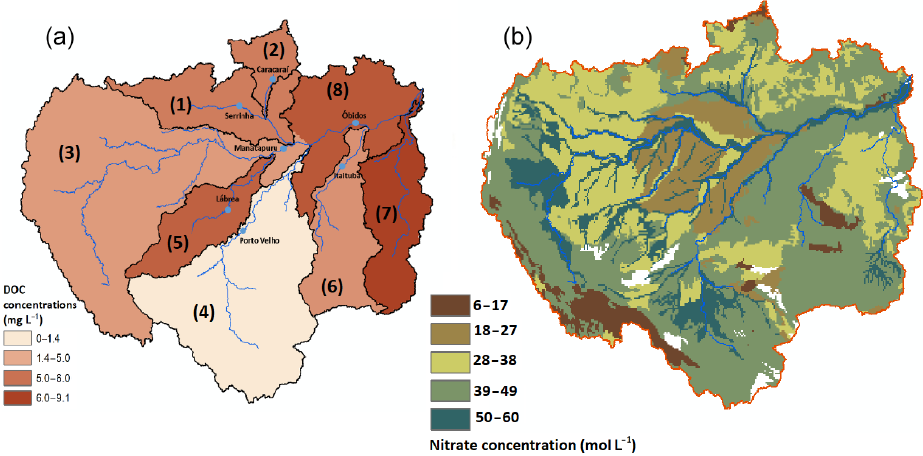
Figure 3. Map of the spatial inputs of the denitrification model. DOC contents (mgL − 1 ) mapped over each sub-basin of the main streams (January) with local observation gauging stations in blue circles (a) . The Amazon watershed is divided into eight major sub-basins: (1) the Negro basin, (2) the Branco basin, (3) the Solimões River and its tributaries, (4) the Madeira basin, (5) the Purus basin, (6) the Tapajós basin, (7) the Xingu basin and (8) the section between Manaus and the mouth of the Amazon River. NO − FAO’s types of soil (b)